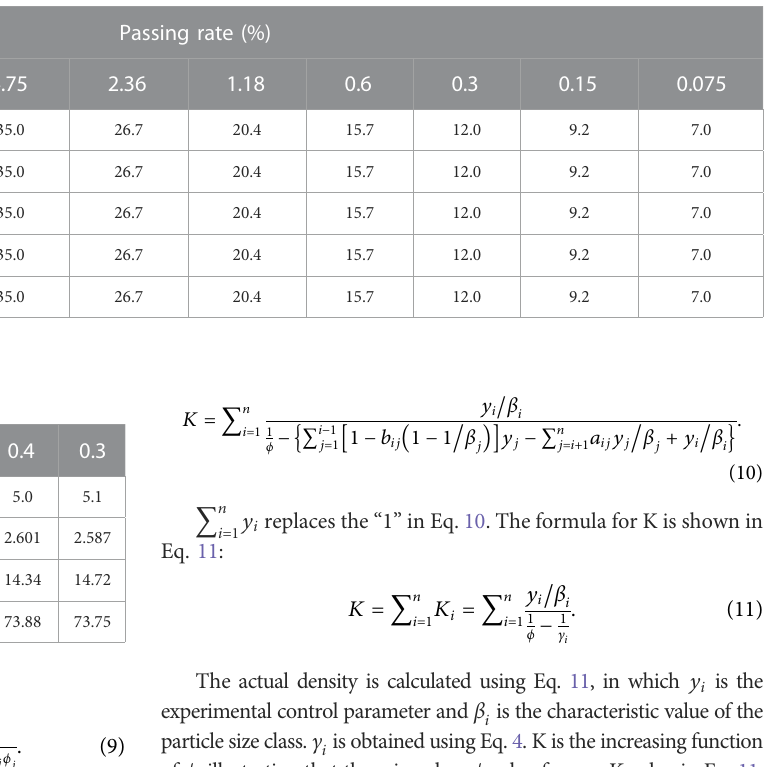
TABLE 4 Gradations on AC-13 containing different matrix compaction indexes.